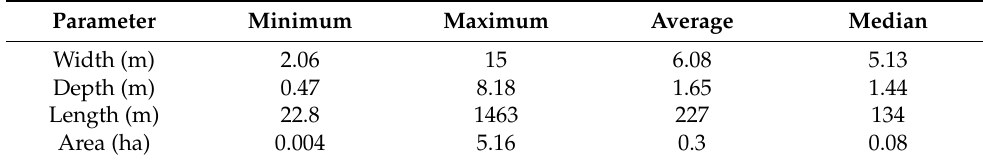
Table 4. Statistical summary of the 56 surveyed gullies.